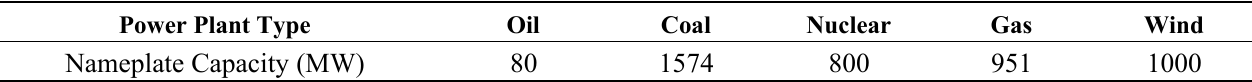
Table 2. Resource mix.